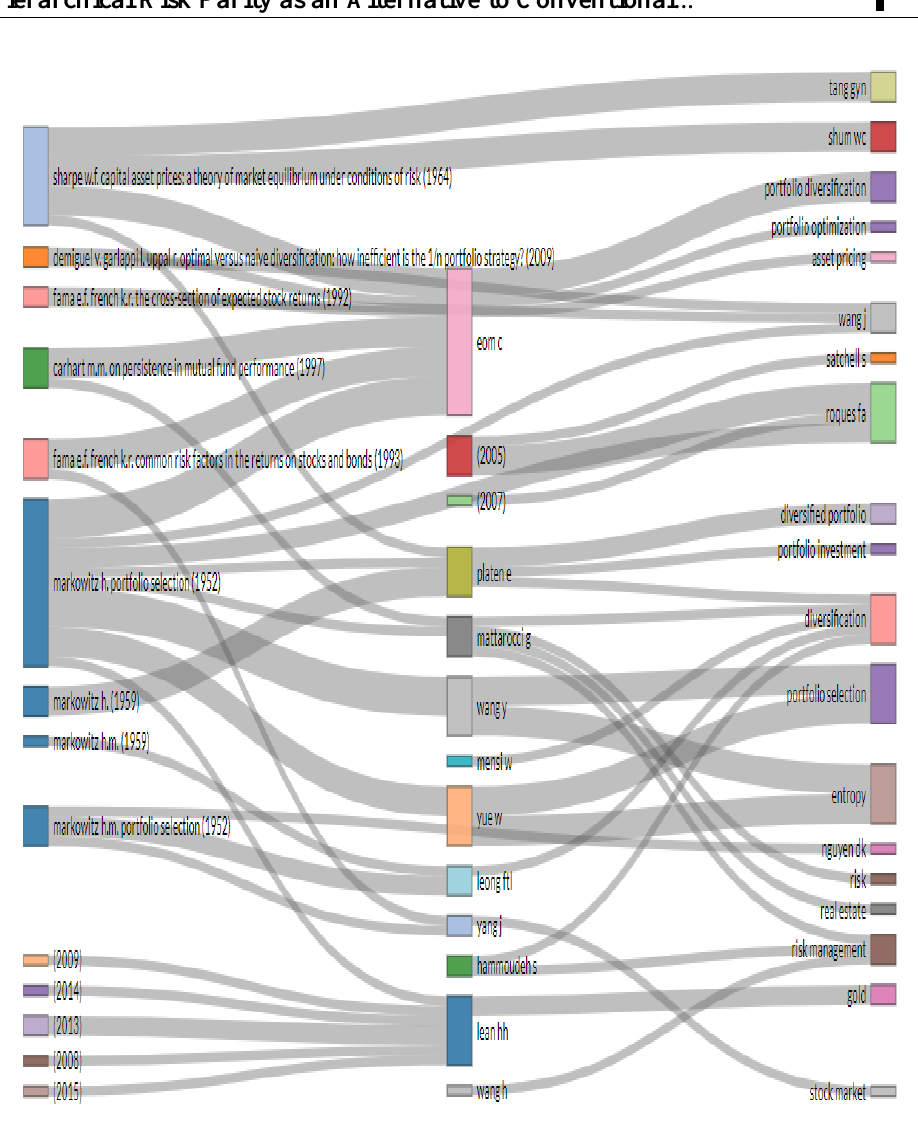
Fig 2. Financial network, the relationship between authors, keywords, and research